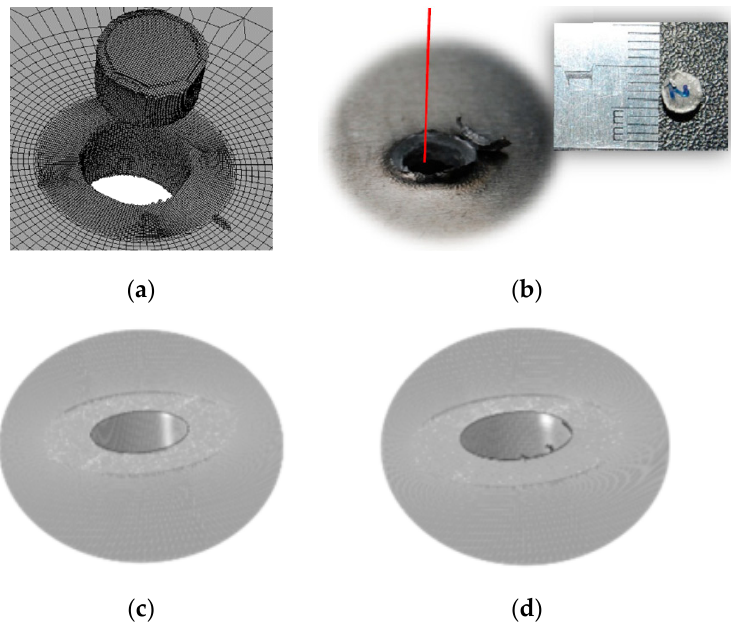
Figure 23. Comparisons of the numerically predicted perforation modes with the experimental observation for the perforation of the 4 mm thick 2024–T351 aluminum alloy plate struck transversely by the 5.5-mm-diameter flat-ended projectile. ( a ) The present model; ( b ) the experimental observation [53]; ( c ) the JC constitutive model with the JC failure criterion [53]; and ( d ) the JC constitutive model with the BW fracture criterion [53]. Adapted from [53] with permission from MDPI, 2018.